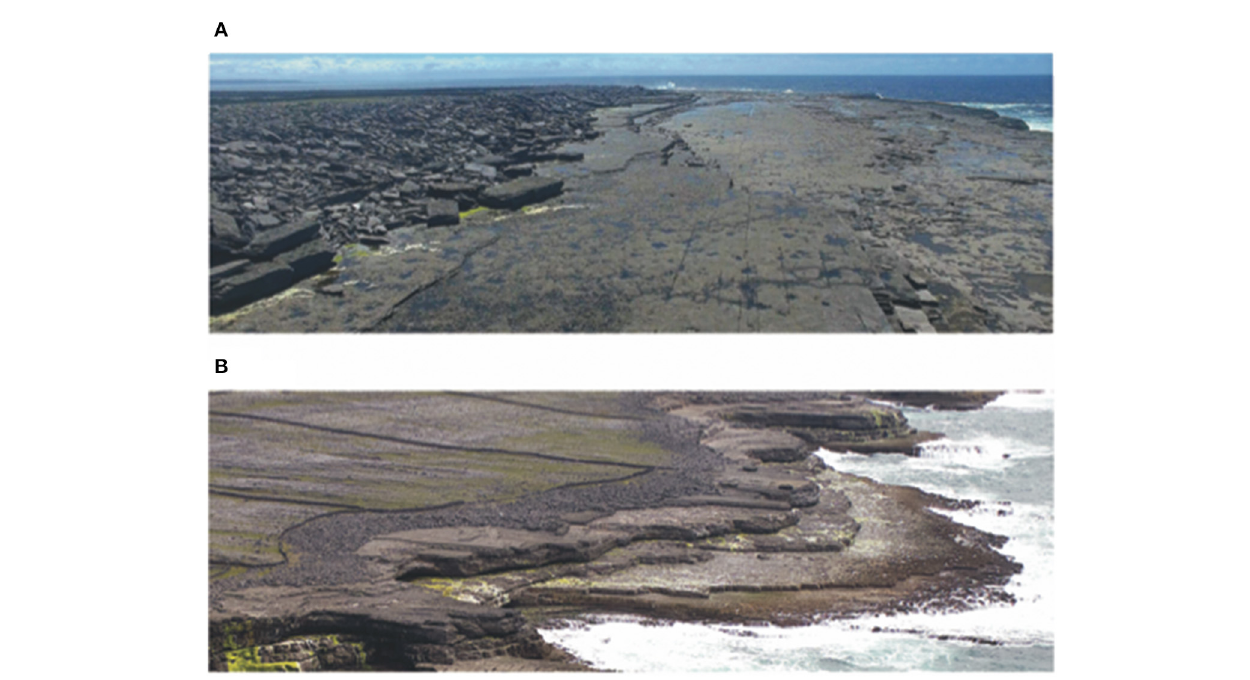
FIGURE 1 | Aerial images showing two examples of CBD on the Aran Islands. In both images, west is to the right. (A) Broad coastal platform on Inishmaan, locations 60–62 ( Supplementary Table 1 ). The large boulder in the mid-ground is about 8m long and sits 17m above high water. The platform is coast on Inishmore, locations 27–29 ( Supplementary Table 1 ). The upper platform is 45m wide at its widest point in the mid-ground. The tide is not full, and the dark brown portion of the lower platform is the exposed intertidal zone. The front edge of the boulder ridge is 18m above and 95m inland of the high tide